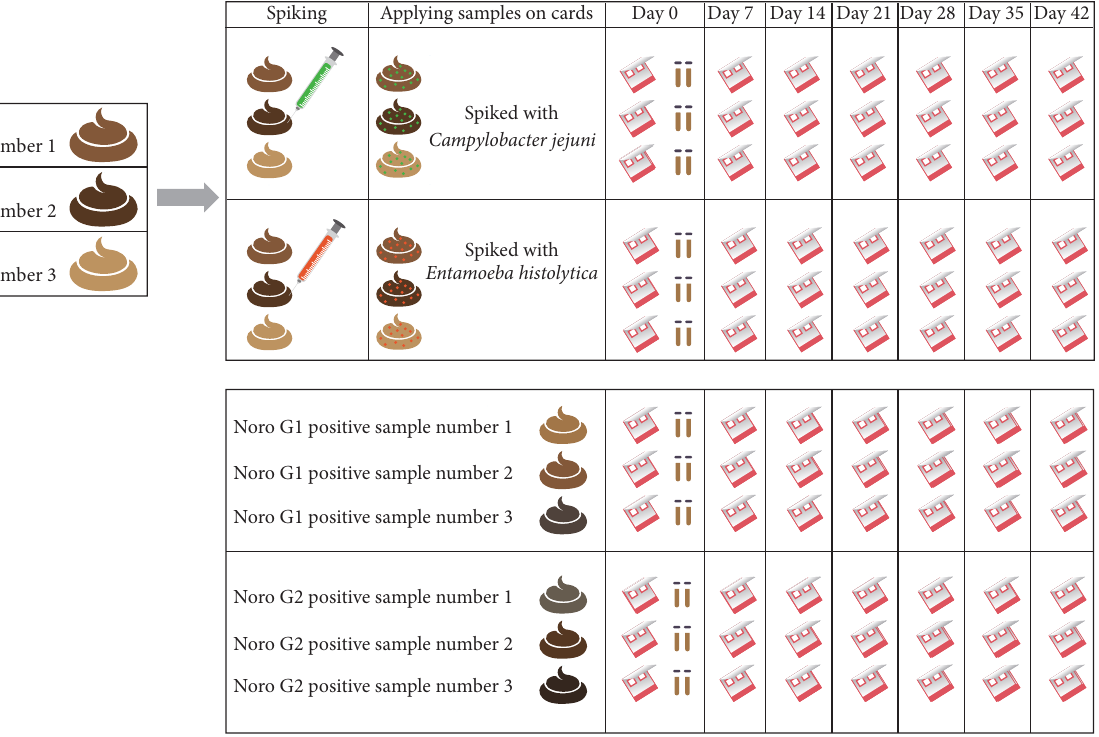
Figure 1: Schematic description of the preparation of the native and stool card samples for the storage